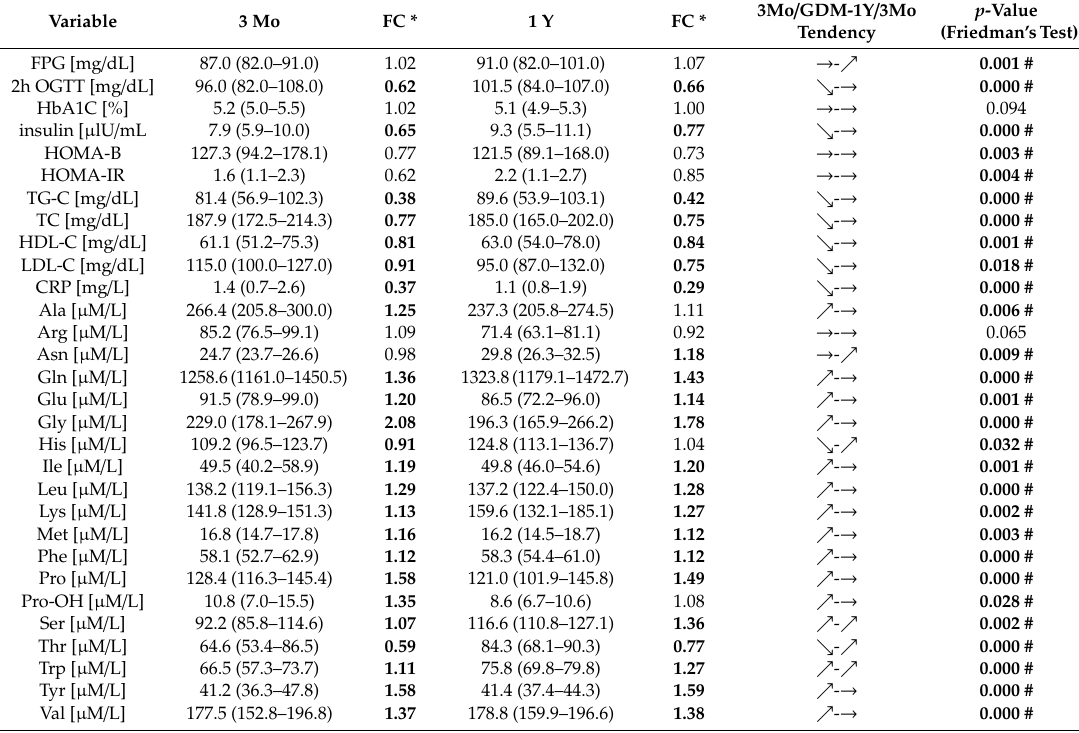
Table 4. Biochemical characteristics of the follow-up GDM group in two time points: 3 months after delivery (3 Mo) and 1 year postpartum (1 Y). Data compared to the 3rd trimester of pregnancy time point and expressed as a fold-change